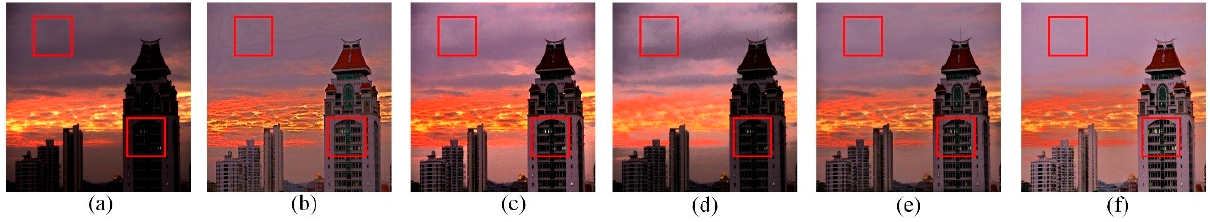
Figure 21. Buildings image. ( a ) Original image; ( b ) result of Lee’s method; ( c ) result of LIME; ( d ) result of AGCWD; ( e ) result of SIRE; ( f ) result of the proposed method.